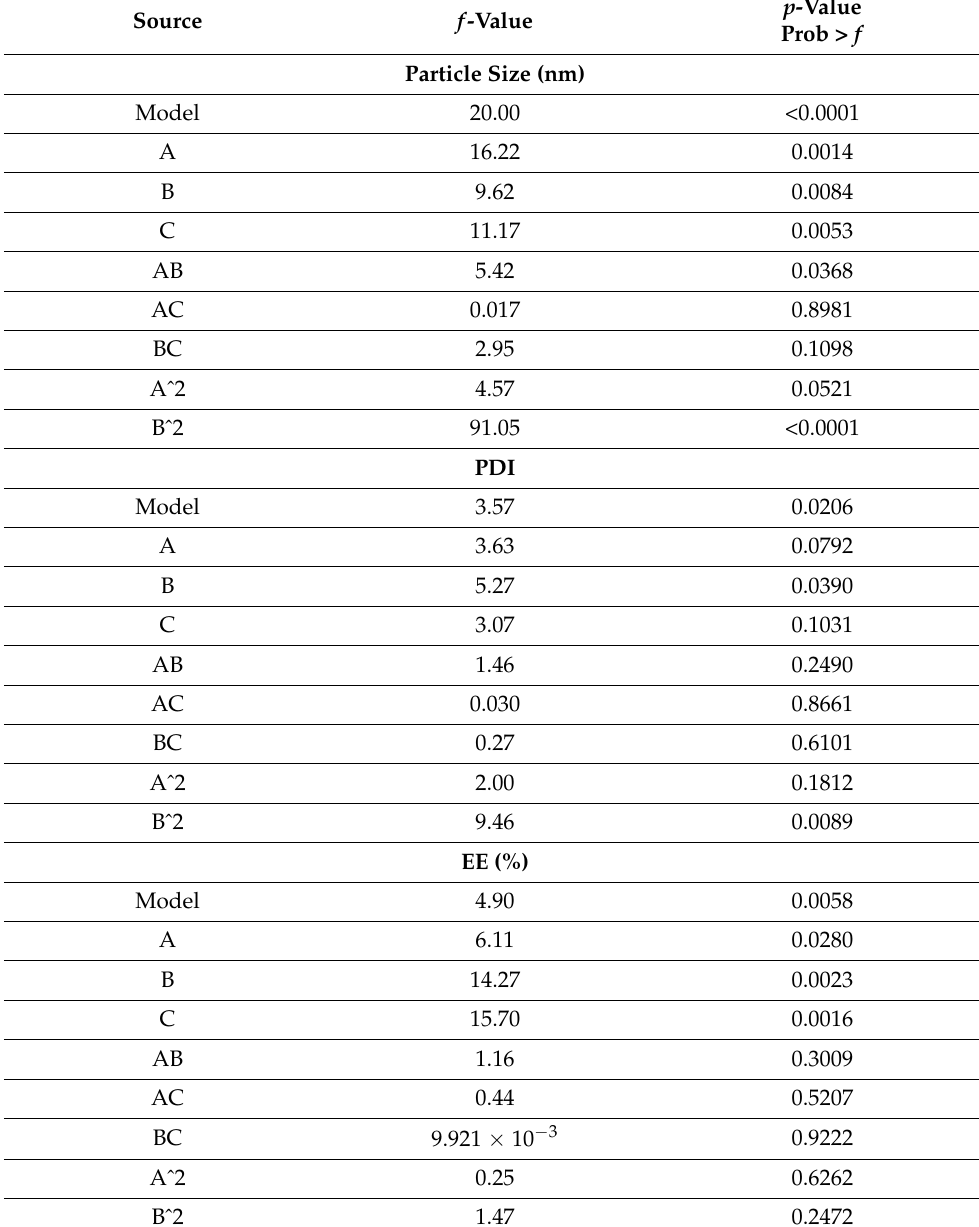
Table 2. Analysis of variance of entrapment efficiency (EE), particle size, and PDI for quadratic polynomial